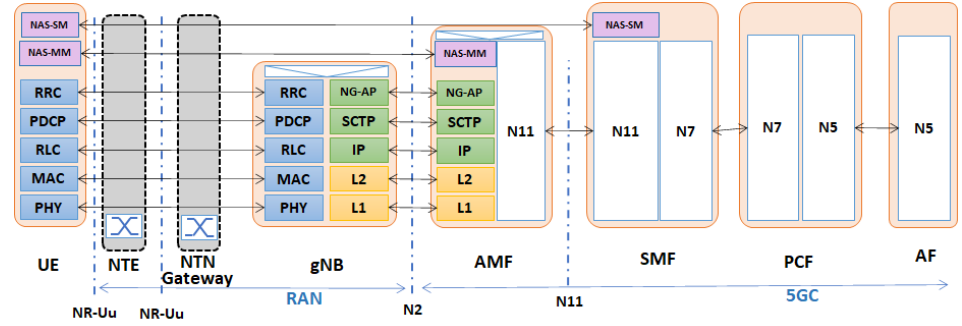
Figure 4. Protocol stack of the control plane in the transparent NTN architecture [27].